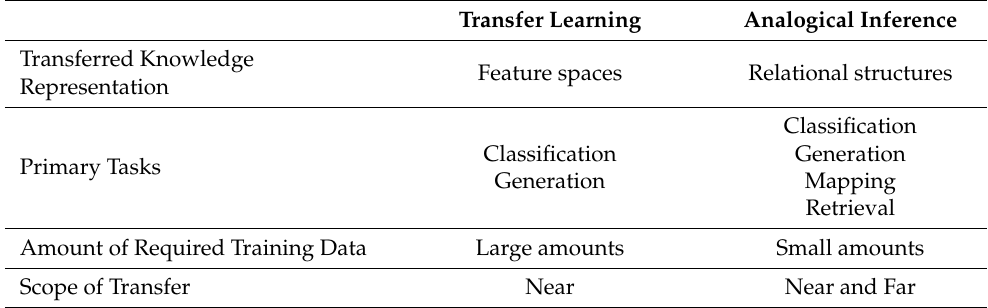
Table 4. High-level comparison between transfer learning and analogical